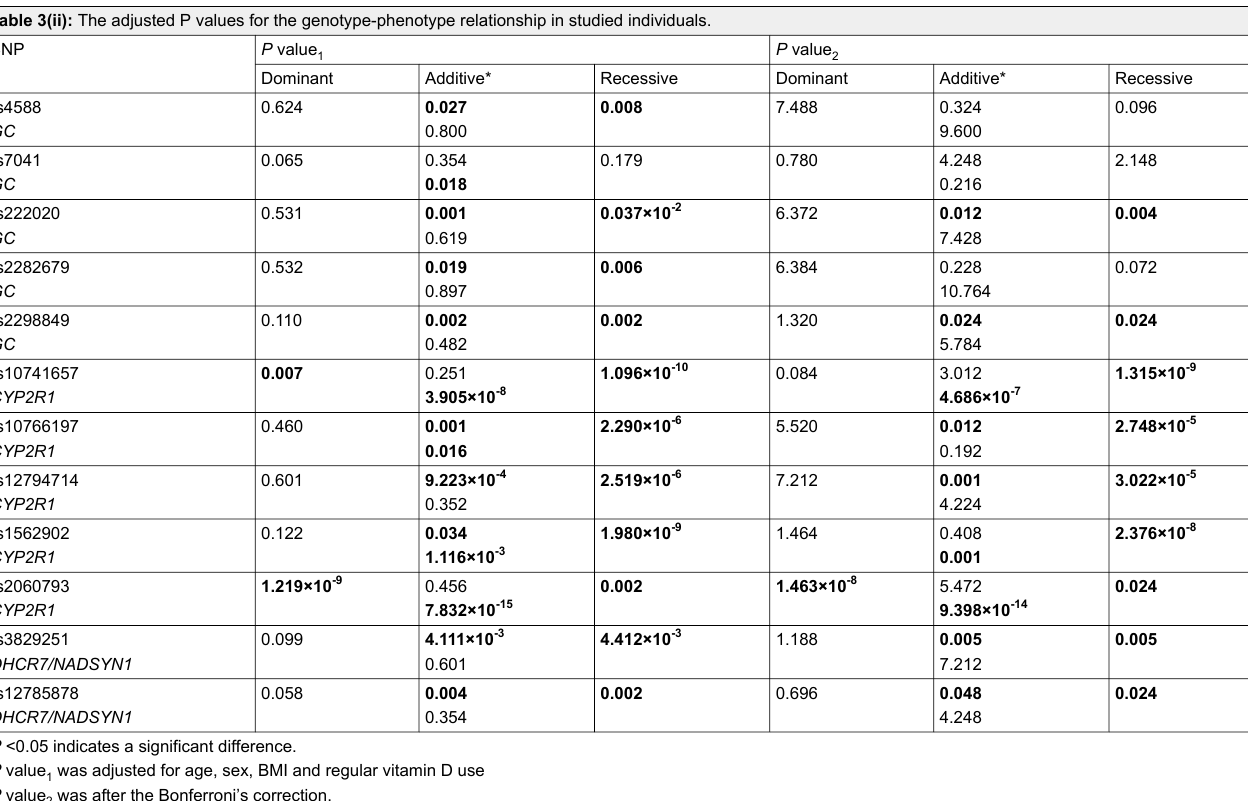
Table 3(ii): The adjusted P values for the genotype-phenotype relationship in studied individuals. P value 1 P value 2 SNP Dominant Additive* Recessive Dominant Additive*